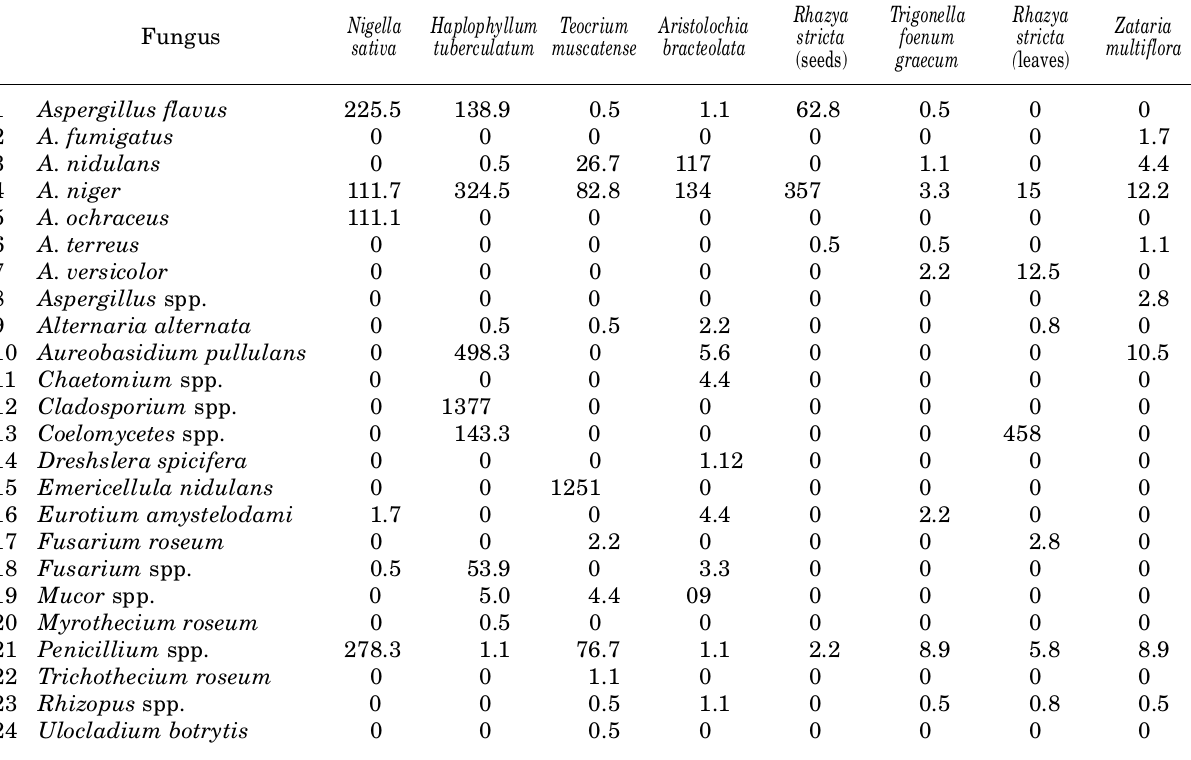
Table 1. Mean number of fungal cfu g -1 on 7 herbal plants.